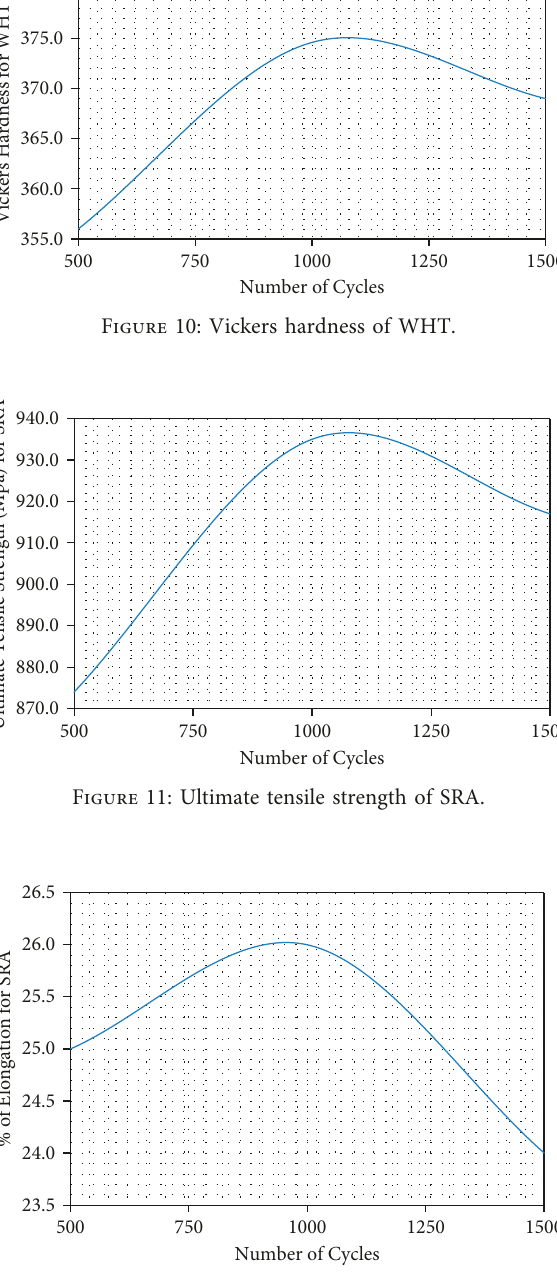
Figure 12: % of elongation of SRA.